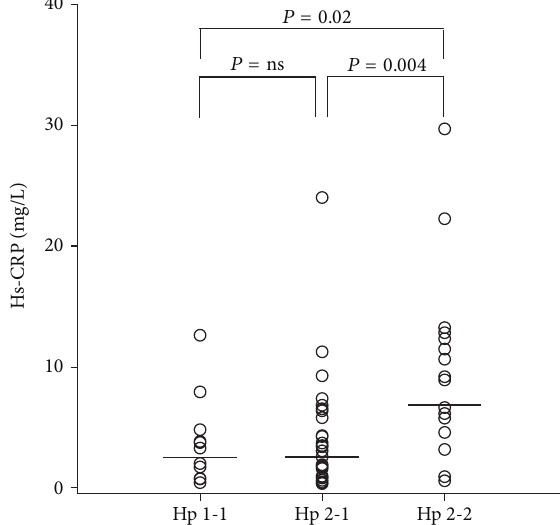
Figure 2: Dot plot showing high-sensitive C-reactive protein (mg/L) in haptoglobin genotypes 1-1, 2-1, and 2-2, respectively. The lines represent mean values. Abbreviations: Hp: haptoglobin and hs- CRP: high-sensitive C-reactive protein.